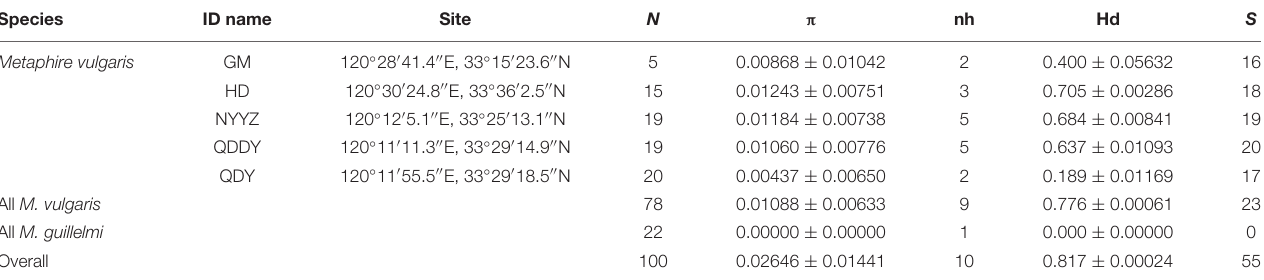
TABLE 1 | Geographic locations of sampling sites and haplotypes.